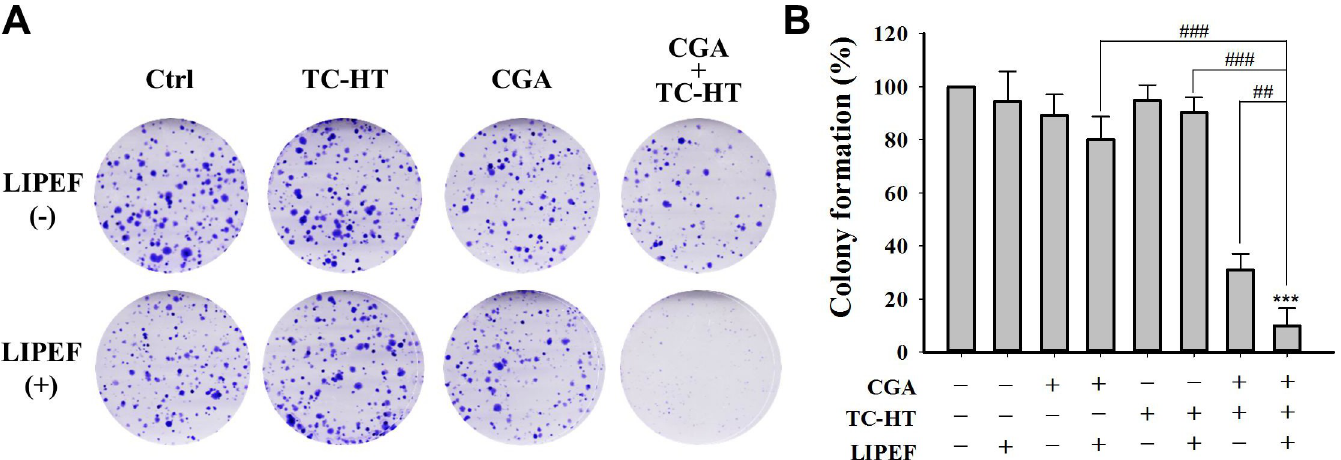
Fig 3. Triple treatment suppresses colony formation of PANC-1 cells. (A) Clonogenic survival assay results for PANC-1 cells treated with CGA (200 μ M), TC-HT (10-cycles), and LIPEF (60 V/cm) alone, in double or triple combination. Images are representative of three independent experiments. (B) Analysis of colony formation rate. Data are presented as mean ± S.D. in triplicate. ( ��� p < 0.001 vs. untreated control; ## p < 0.01 and ### p < 0.001 between indicated